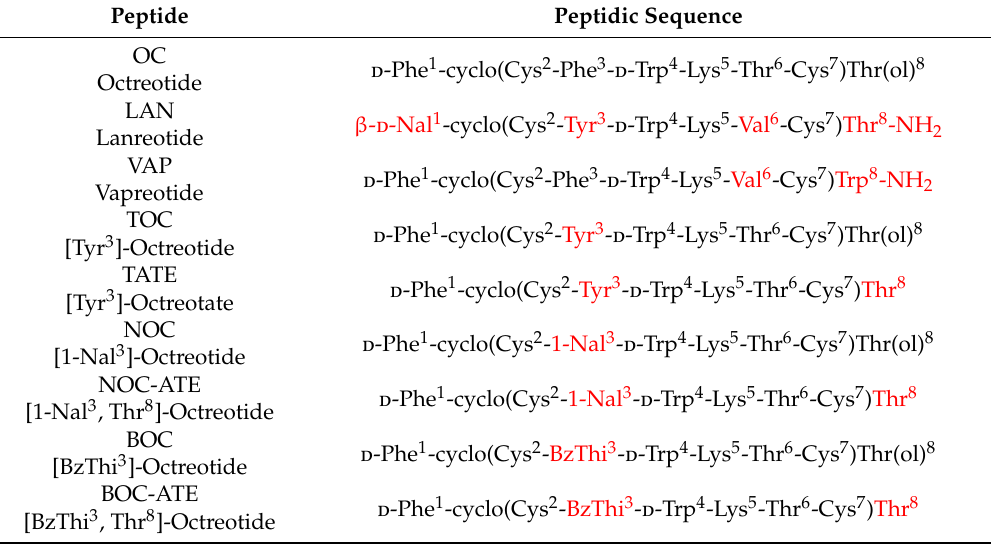
Table 3. Peptidic sequences of the main somatostatin agonist analogs. Di ff erences towards Octreotide (OC) are highlighted in